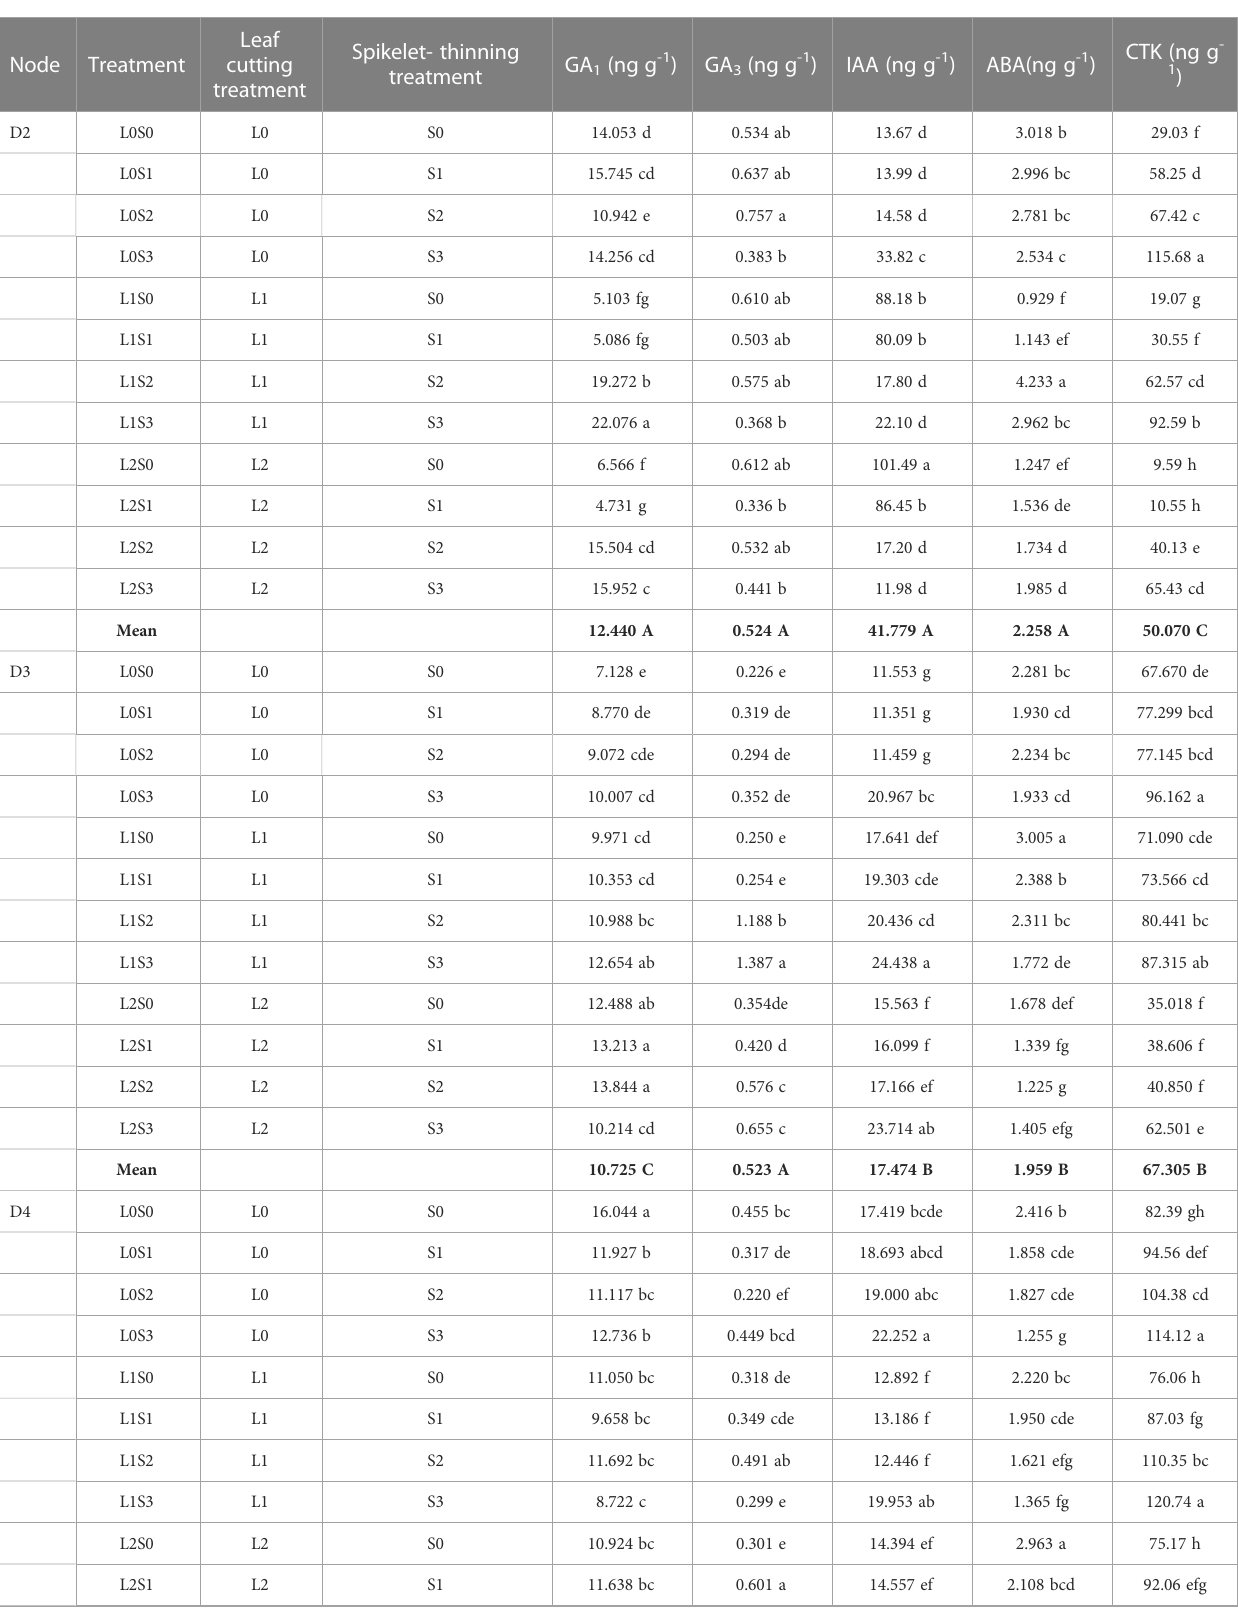
TABLE 3 Changes of endogenous hormone content in stems and buds at separate nodes at 15 days after leaf-cutting and spikelet-thinning treatment in 2019.